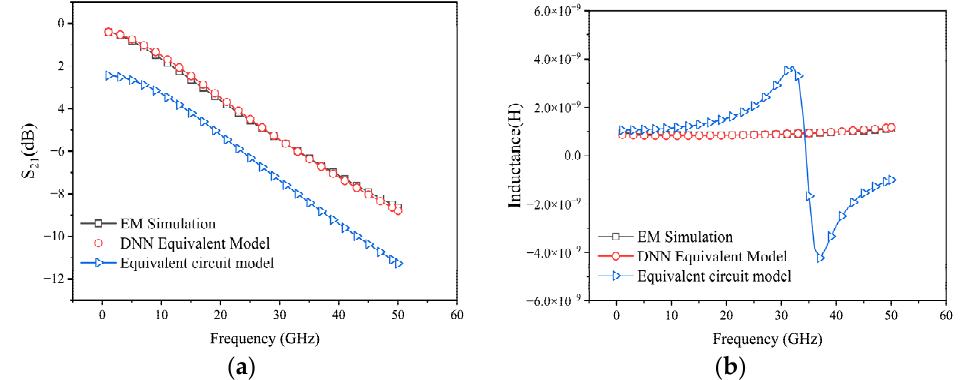
Figure 9. S-parameters (S 21 ) and inductance values for a metal filling density of 50%; ( a ) shows S-parameters (S 21 ) and ( b ) shows inductance values.